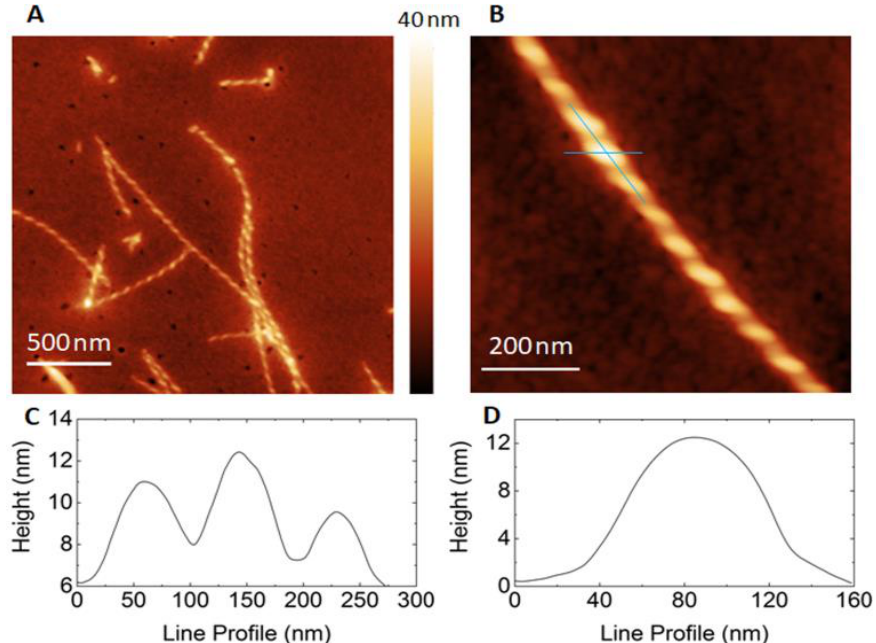
Figure 7. AFM characterization of peptide 1 supramolecular structure, drop-casted onto mica surface. In ( A , B ), representative AFM images of the fibrillar structure on the mica surface are shown. Cross sections through the structure are shown below: ( C ) corresponds to the line profile along the fibril structure (reported in ( B ) as a vertical blue line); ( D ) corresponds to the horizontal line profile (reported in ( B )).